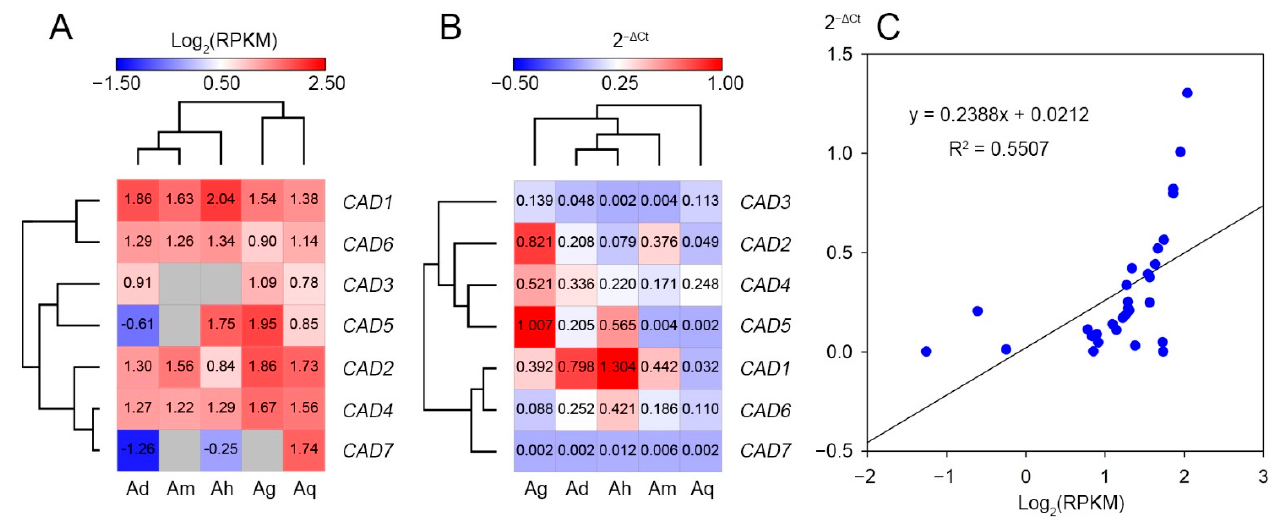
Figure 4. Expression analysis of agave CAD genes by RNA-Seq ( A ), qRT-PCR ( B ) and correlation analysis of the two methods ( C ). Grey squares without numbers represent no data obtained by RNA-Seq. The clusters of genes and species were calculated by the hierarchical clustering method in A and B [46].